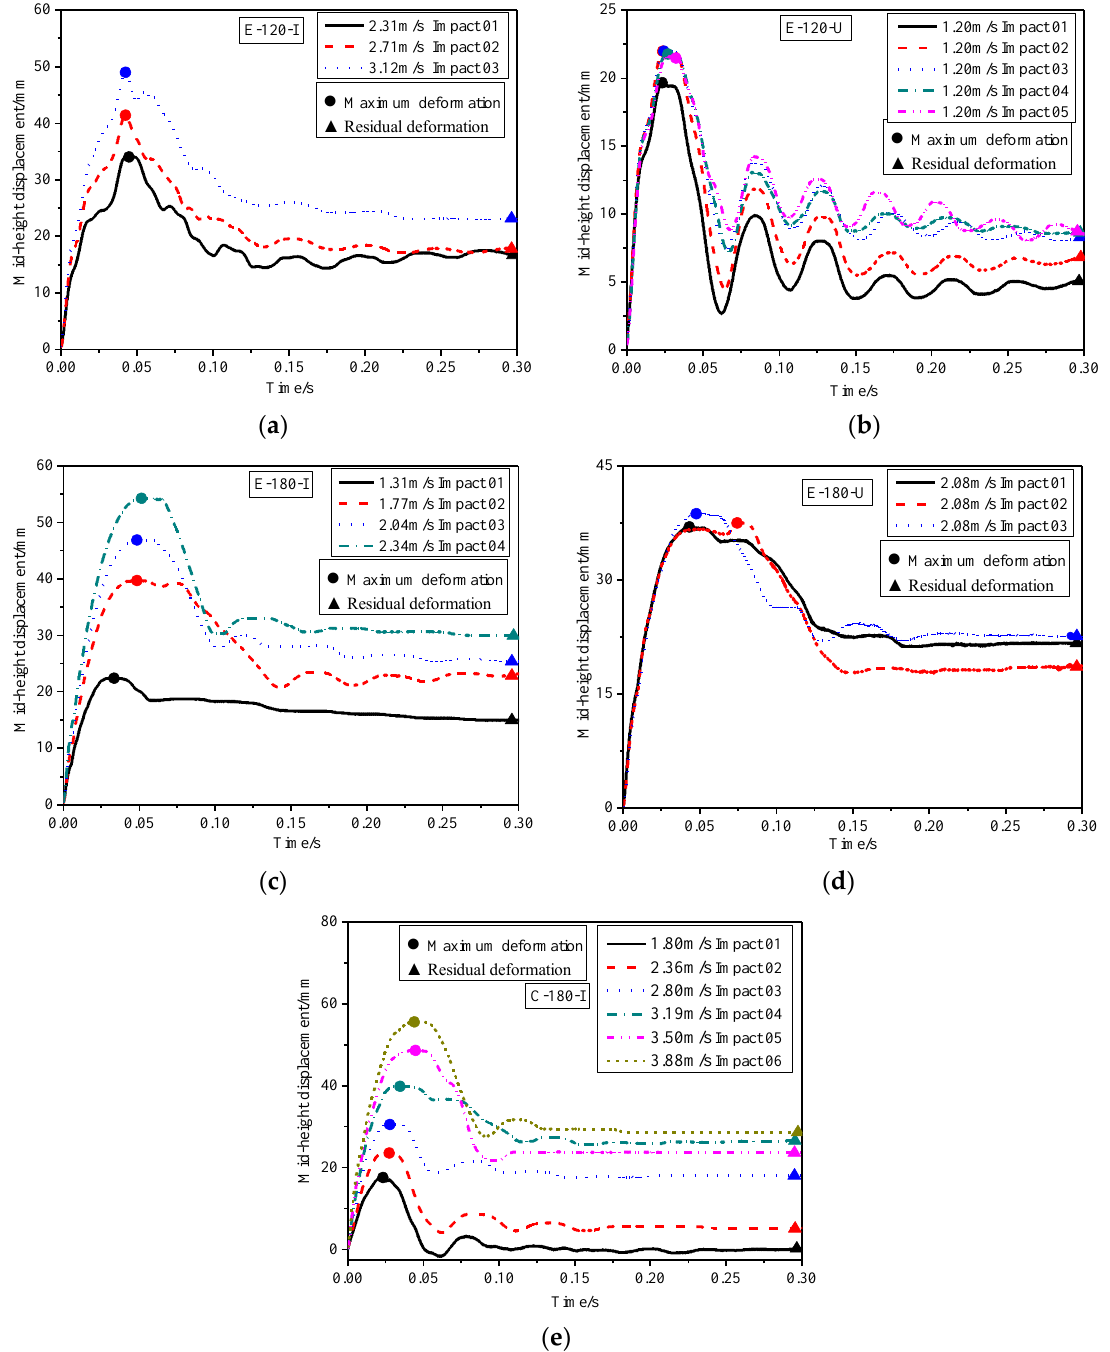
Figure 7. Mid-height displacement time histories of the columns. ( a ) E-120-I; ( b ) E-120-U; ( c ) E-180-I; ( d ) E-180-U; ( e ) C-180-I.